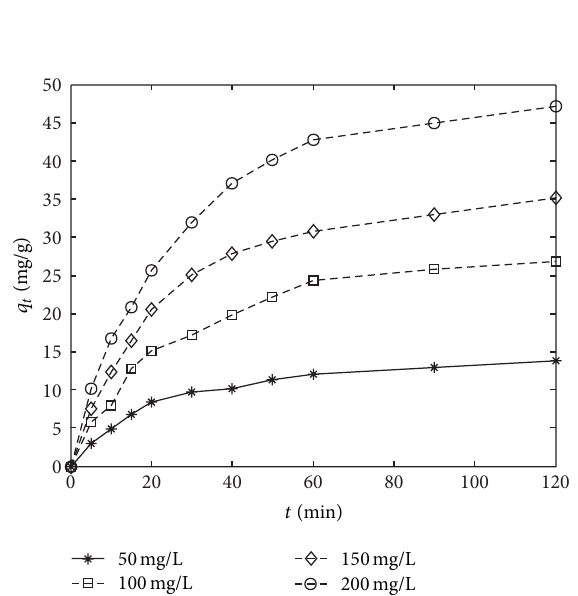
Figure 14: Ho pseudosecond-order kinetics for MB onto PTMF ( 𝑉 : 1L, pH: 6; agitation rpm: